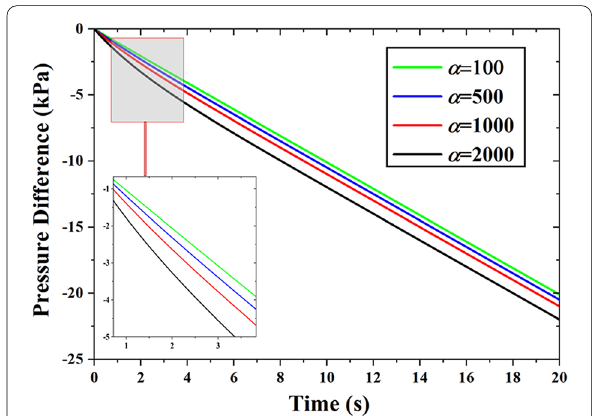
Figure 5 Relationship of α and pressure difference with leakage